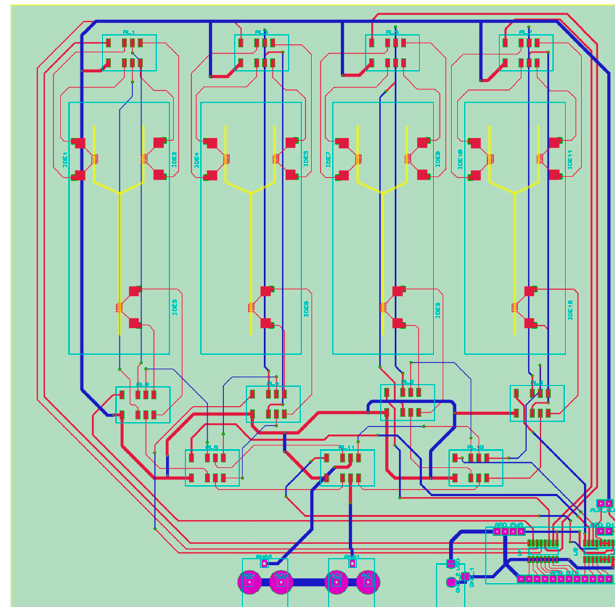
Figure 2. Printed circuit layout in two copper layers containing four sets of interdigitated electrodes (IDE) electrodes (12 total). The yellow lines represent the four Y-shaped microchannels to illustrate their position on the final device. The red, blue, and pink lines are the copper tracks on either side or both sides of the printed circuit boards (PCB). Exposed pads and interdigitated electrodes were gold-plated.